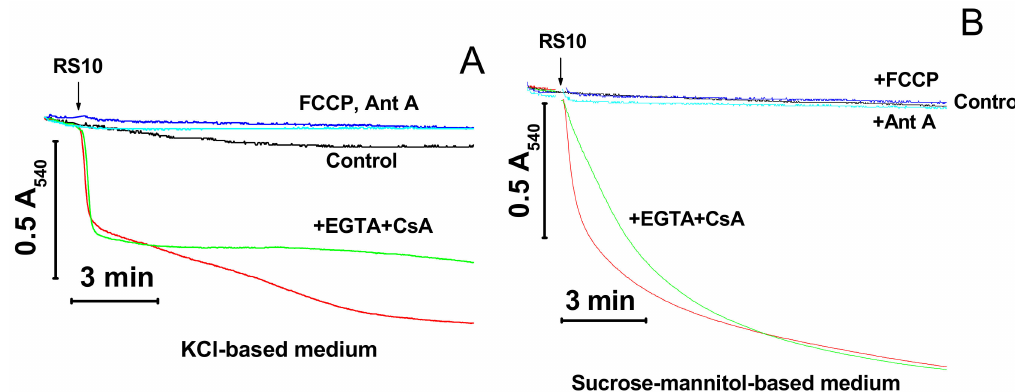
Figure 2. Permeabilization of mitochondrial membranes by FTCs (fusaricidin-type compounds) is membrane potential ( ∆Ψ m )-dependent and permeability transition pore (mPTP)-independent. Immediately before measurements, mitochondria (0.5 mg protein / mL) were added to KCl- ( A ) and sucrose-mannitol-based medium ( B ), supplemented with 5 mM glutamate and 5 mM malate. The arrow indicates the addition of the RS10 extract (15 µ g / mL) to all samples except control (black). Where shown, media also contained 0.5 mM EGTA and 2 µ M CsA (cyclosporin A) (green), antimycin A (2 µ g / mL) (Ant A, blue), and 0.5 µ M FCCP (carbonyl cyanide p-(trifluoromethoxy)phenyl-hydrazone) (navy blue). Representative data of one experiment of at least three similar are shown. The experiments were performed at 23 ◦